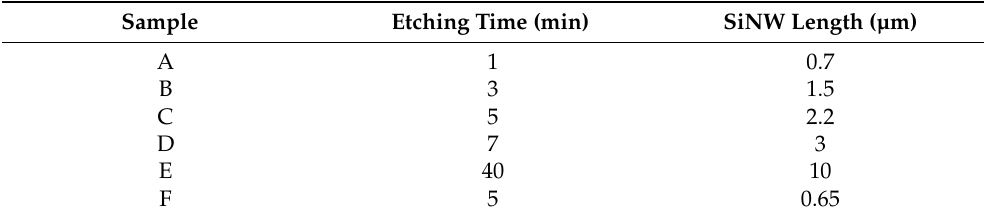
Table 1. List of samples with different etching times and corresponding lengths. Samples A, B, C, D, and E are random wires, and sample F is with periodic wires (shown in the Supplementary Material).